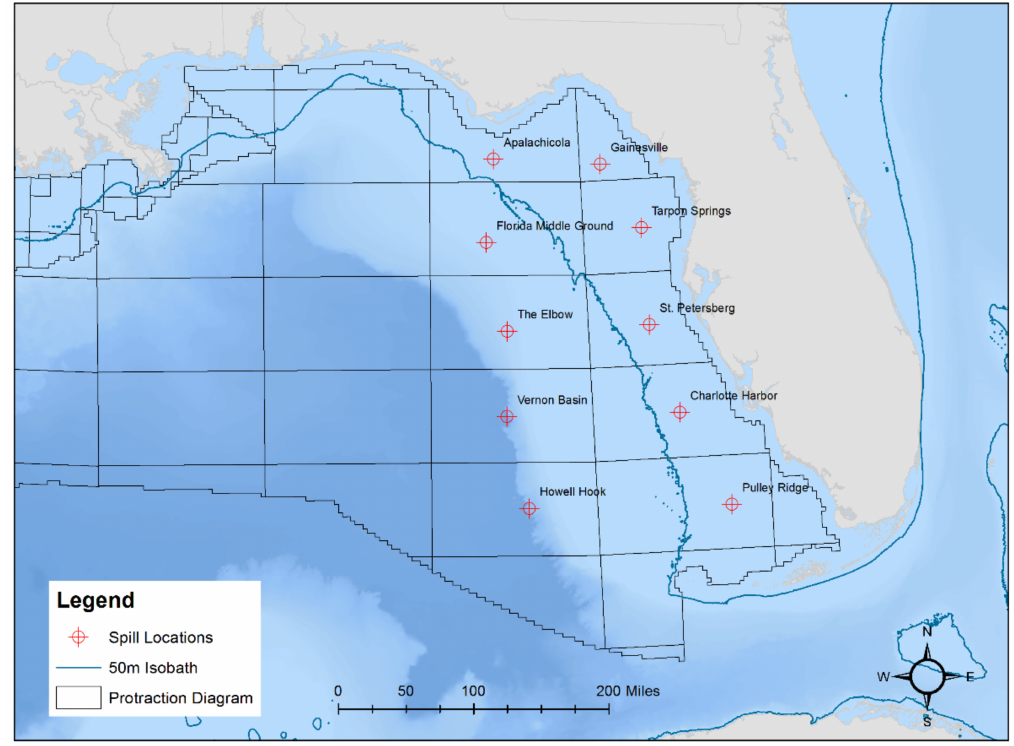
Figure 1. Study area and the set of locations used for spill simulation. Scenario names are derived from the name of the protraction block in which they